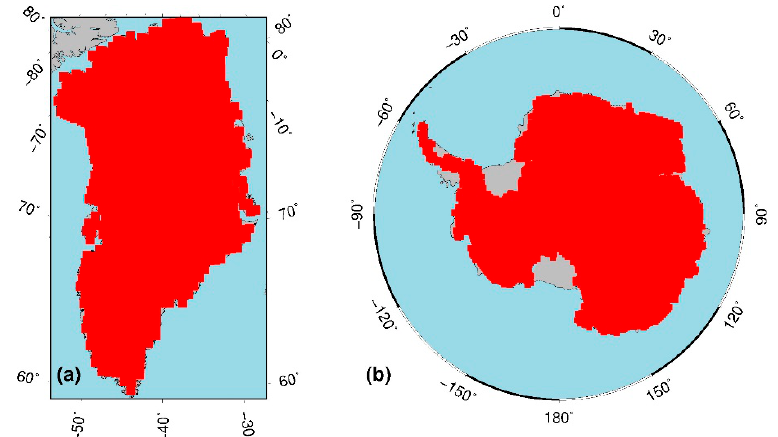
Figure 1. Geographic locations of the study regions in red: ( a ) the Greenland ice sheet (GrIS) and ( b ) the Antarctic ice sheet